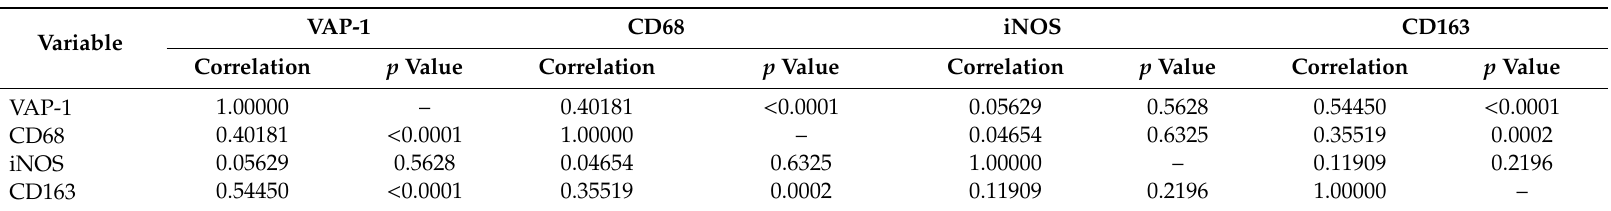
Table 3. Assessment of the relationship between VAP-1 and TAM associated markers (CD68, iNOS, and CD163) by Pearson’s correlation coe ffi cient ( n = 108). Variable